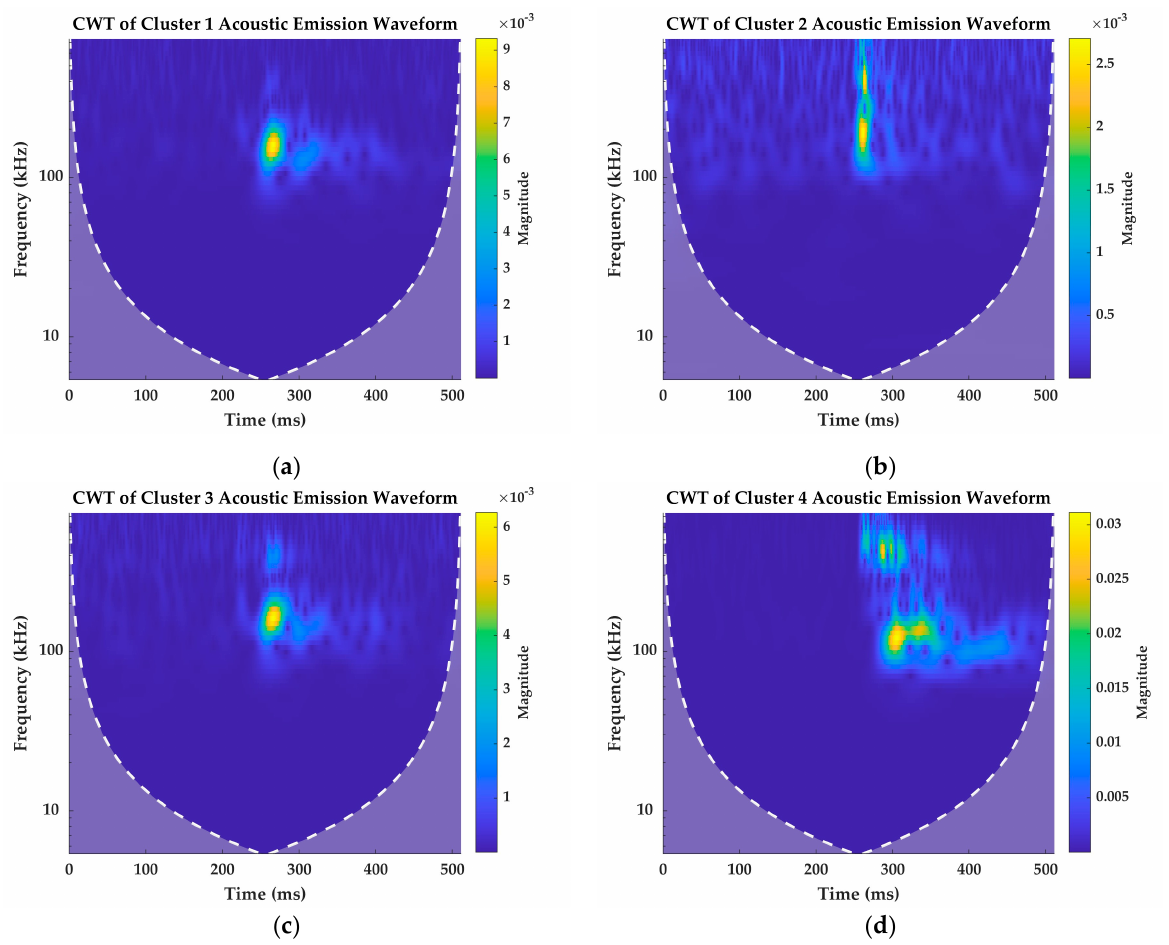
Figure 5. CWT spectrograms of AE signals taken randomly from ( a ) Cluster 1; ( b ) Cluster 2; ( c ) Cluster 3; ( d ) Cluster 4.